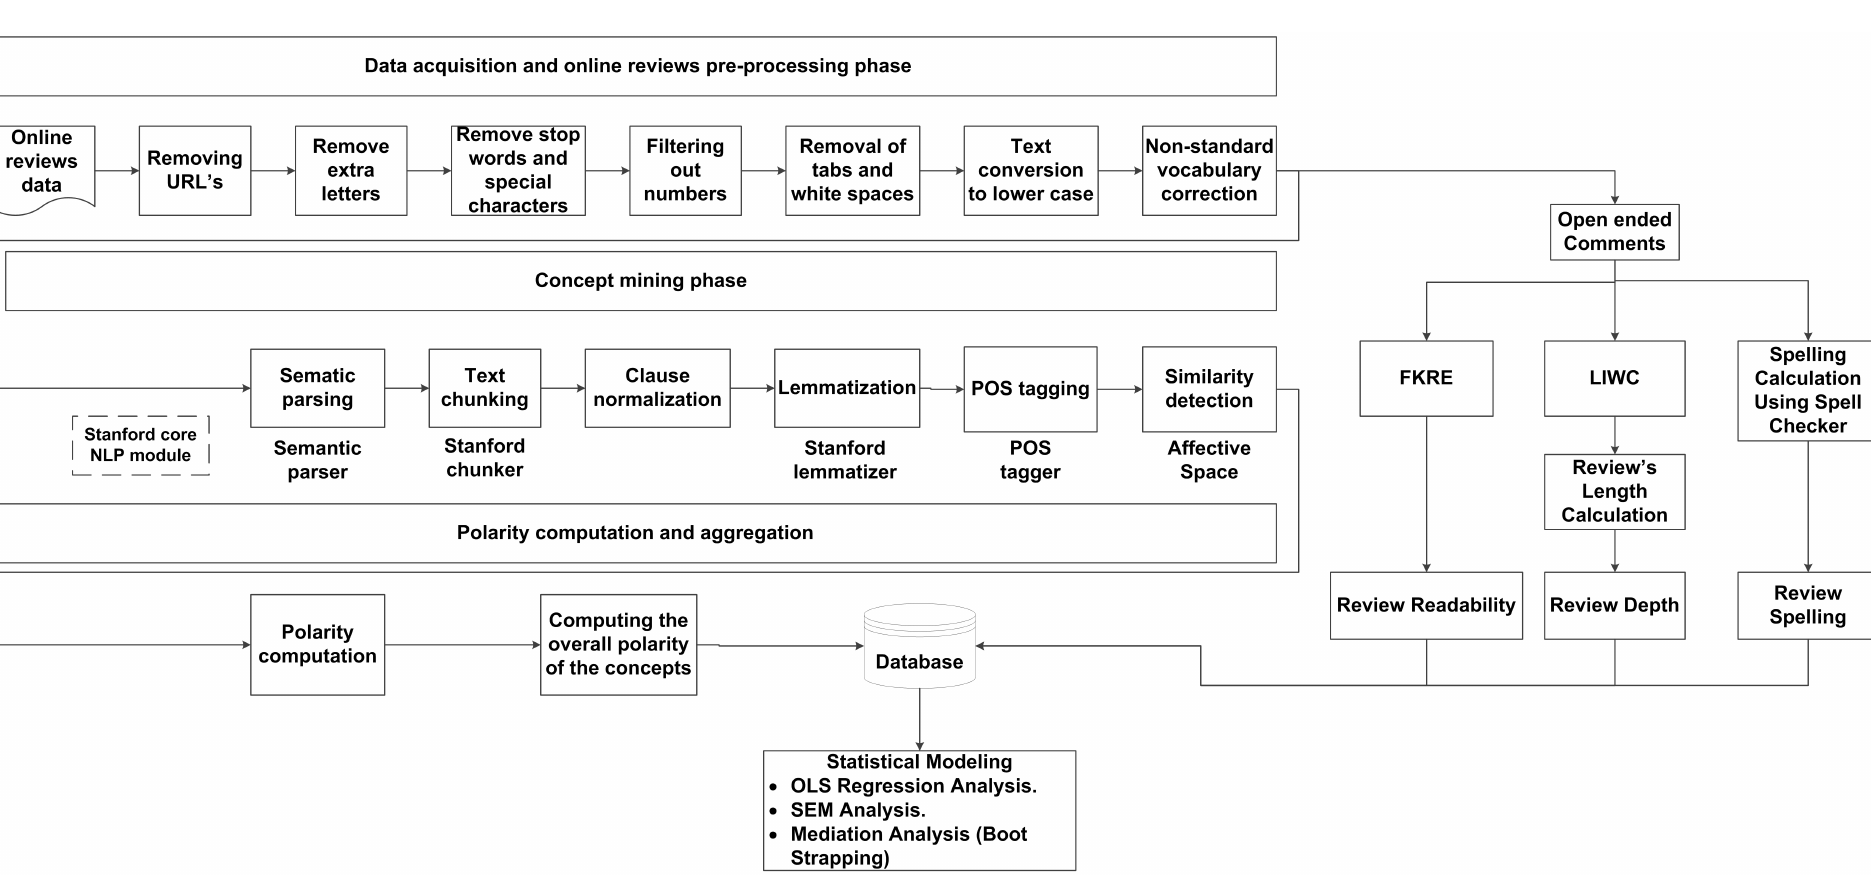
Figure 2. Variable measurement and analysis